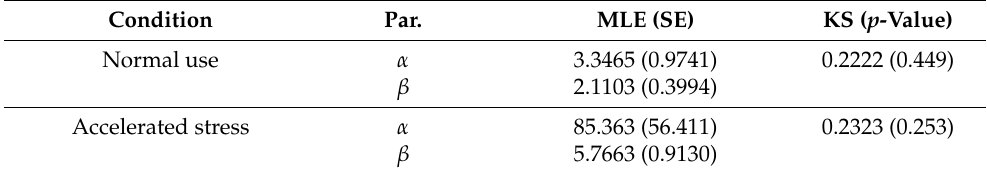
Table 3. MLEs and KS ( p -value) for micro-droplets